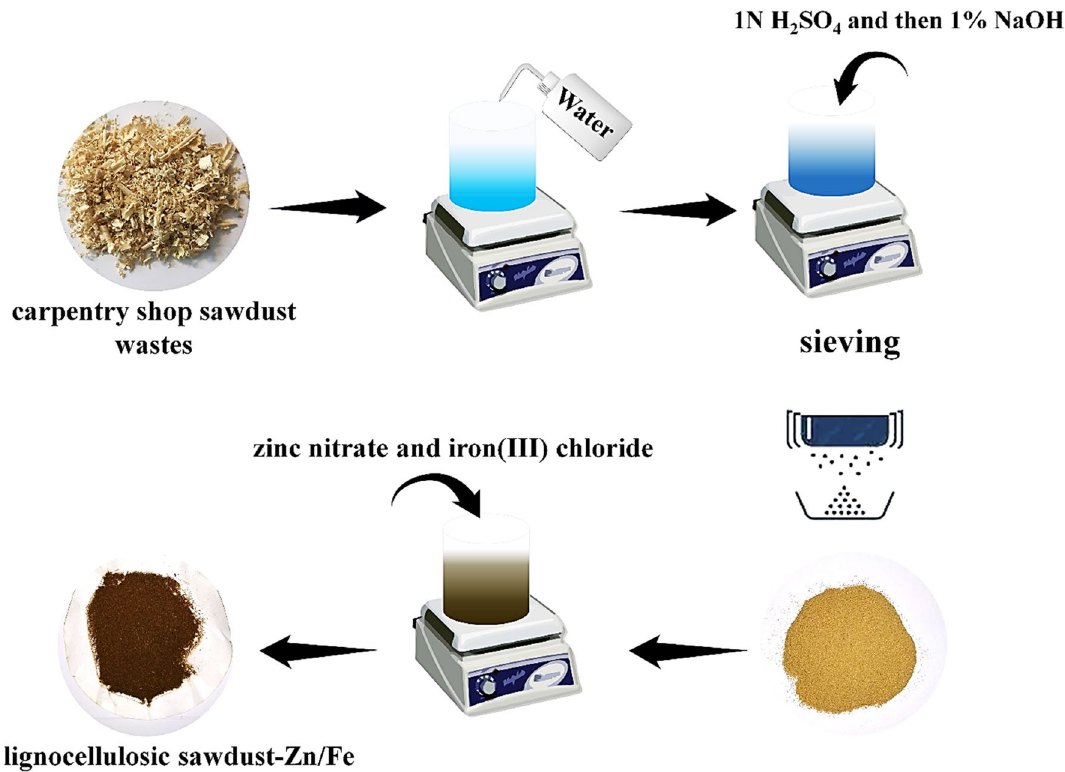
Figure 3. The synthesis schematic of lignocellulosic